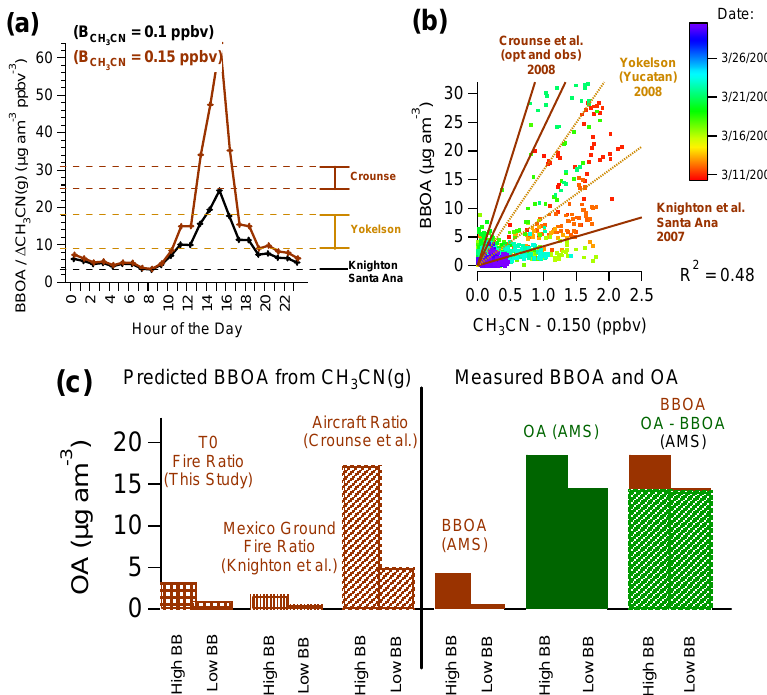
Fig. 14. (a) Diurnal profile of BBOA divided by 1 CH 3 CN at T0 (assuming two different backgrounds), to the right the range of values reported by Crounse et al. (2009), Yokelson et al. (2009), and Knighton et al. (2007) are shown; (b) scatter plot of BBOA vs. CH 3 CN at T0,with lines representing the same previous studies; (c) left: predicted BBOA from CH3CN and different emission ratios for the high fire and low fire periods, right: measured BBOA and OA for the same periods. The BBOA/ 1 CH 3 CN values (µgam − 3 ppbv − 1 ) used are as follows: This study (6.0), Knighton (3.4), Crounse